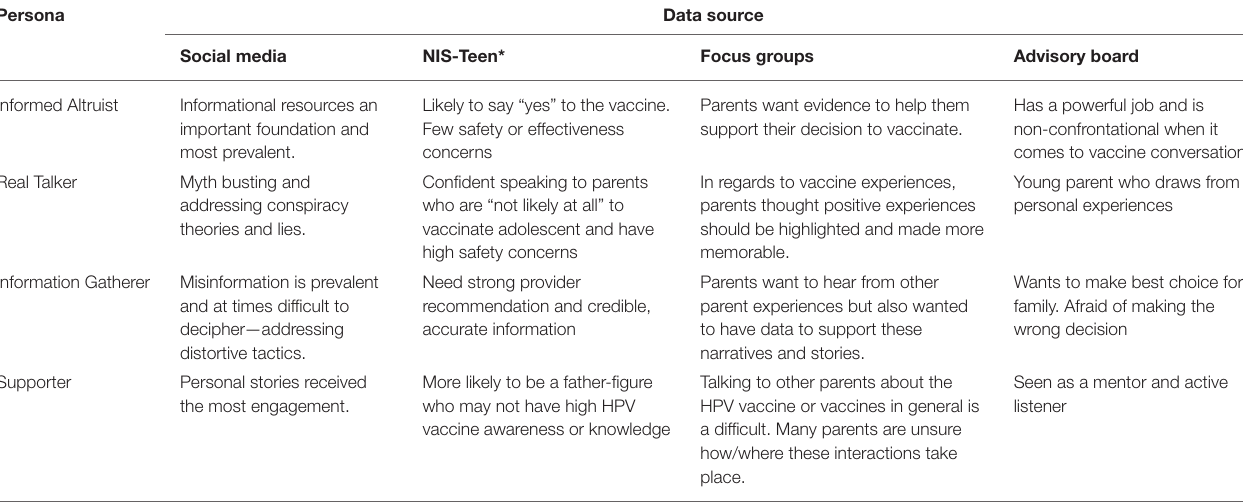
TABLE 1 | Data type and content used to inform development of each